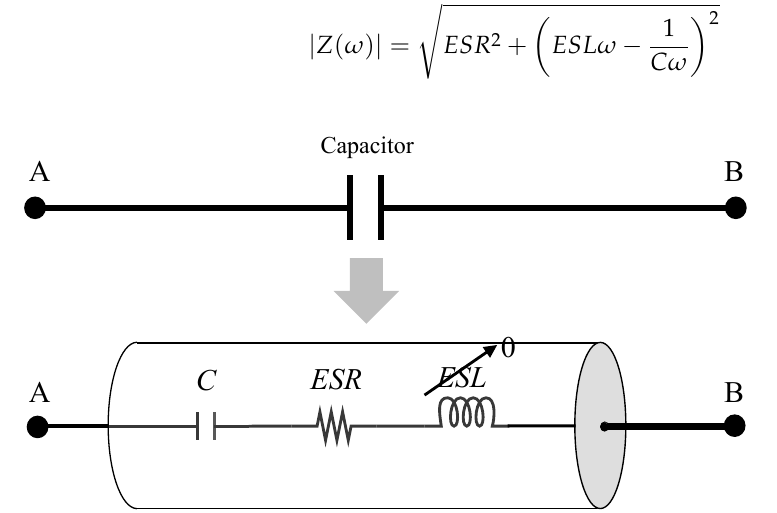
Figure 3. A simplified equivalent model of capacitors